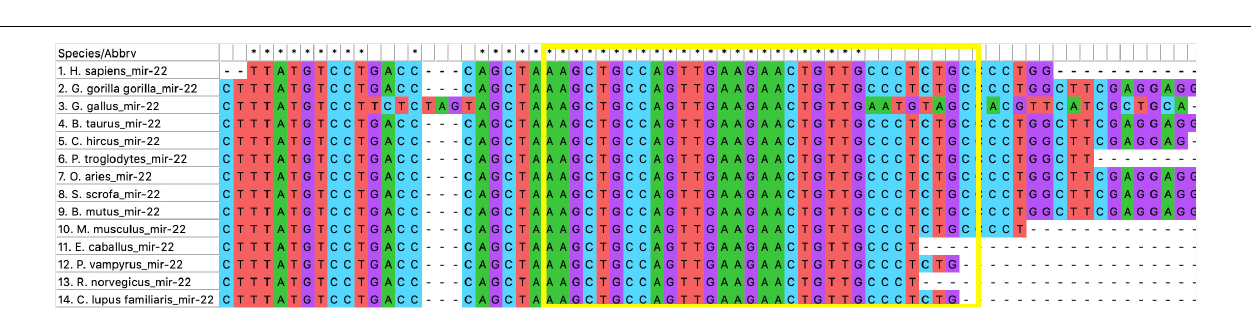
bta-miR-11975, and bta-miR-11976 affect all of the pathways in Table 4